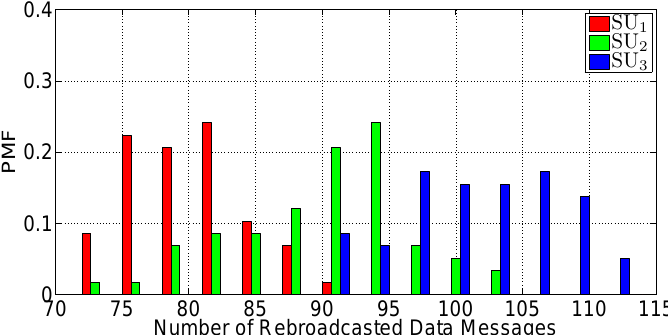
Figure 10. Probability Mass Function (PMF) of rebroadcast DATA messages in Scenario